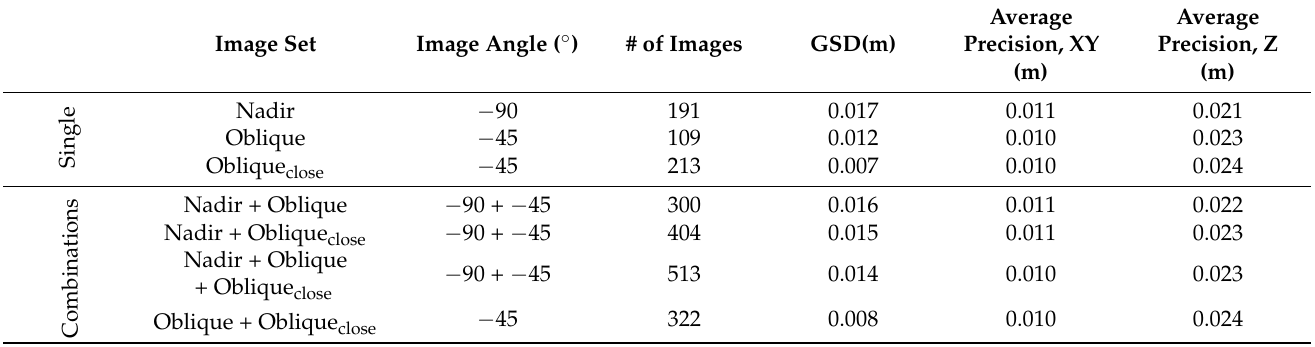
Table 1. Image sets collected during UAV flight and combination scenarios for